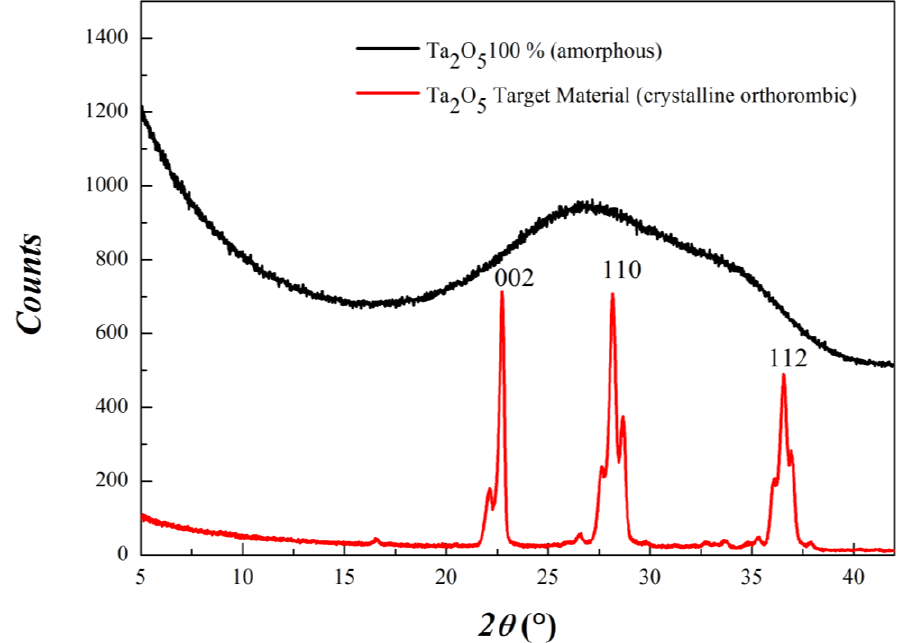
Figure 5. Comparison between the diffractograms of Pccm orthorhombic crystalline Ta 2 O 5 ( red line ) and amorphous Ta 2 O 5 ( black line ).